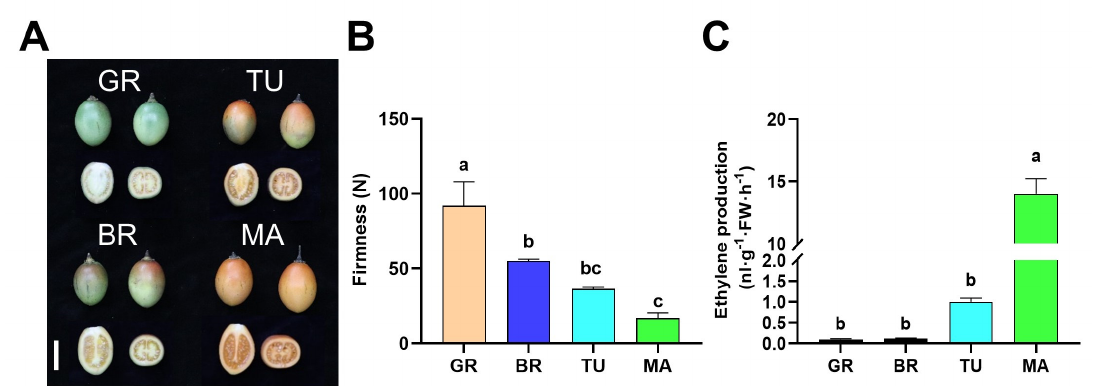
Figure 1. Changes of firmness and ethylene production during tamarillo fruit ripening. The pheno- type ( A ), firmness ( B ), and ethylene production ( C ) of fruits at different ripening stages. Bar = 5 cm. For ( B ), data represent the mean ± SD ( n = 3). For ( C ), data represent the mean ± SD ( n = 4). Means denoted by the different letters significantly differ at p < 0.05 according to Tukey’s test. GR, Green ripe; BR, Break; TU, Turning; MA, Mature. FW: fresh